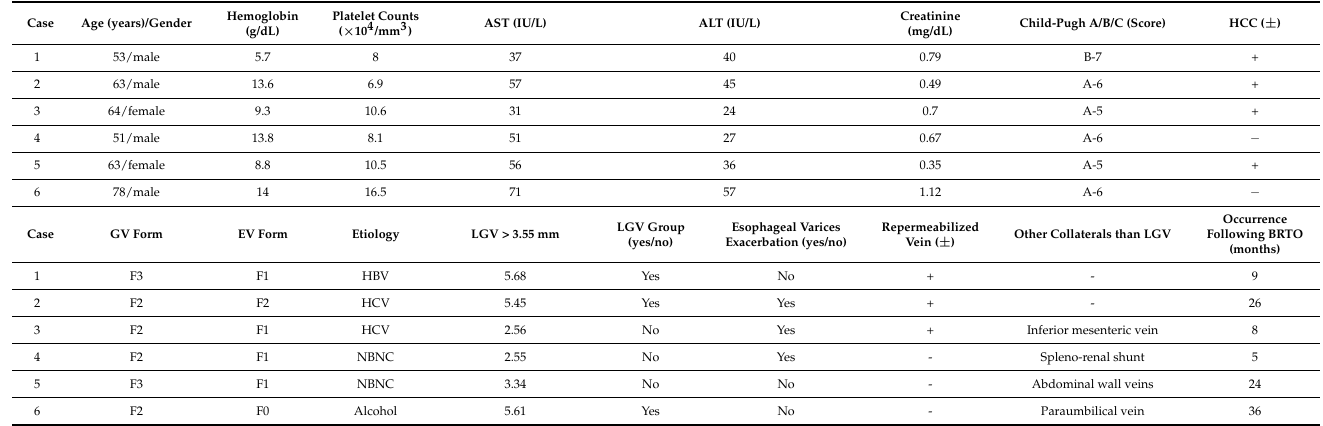
Table 3. Six patients with the development of repermeabilized vein, other collaterals other than left gastric vein, following balloon-occluded retrograde transvenous